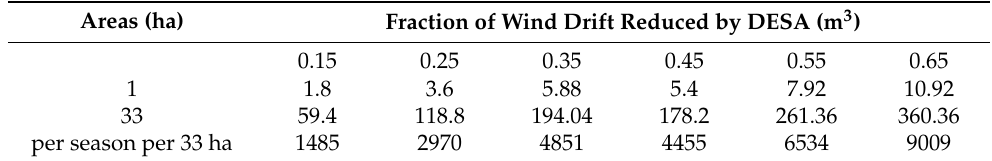
Table 3. Water-saving during irrigation event by using a DESA design with center pivot irrigation. Areas (ha)